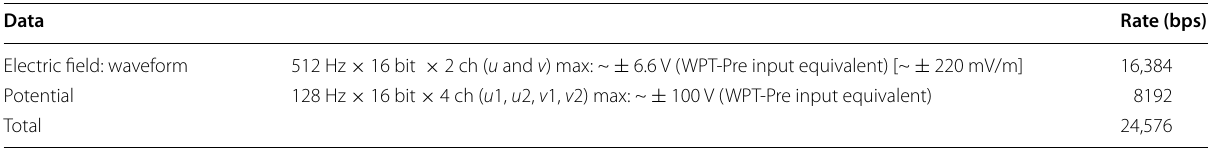
Table 2 Burst-mode data from the EFD system (raw data) Data Electric field: